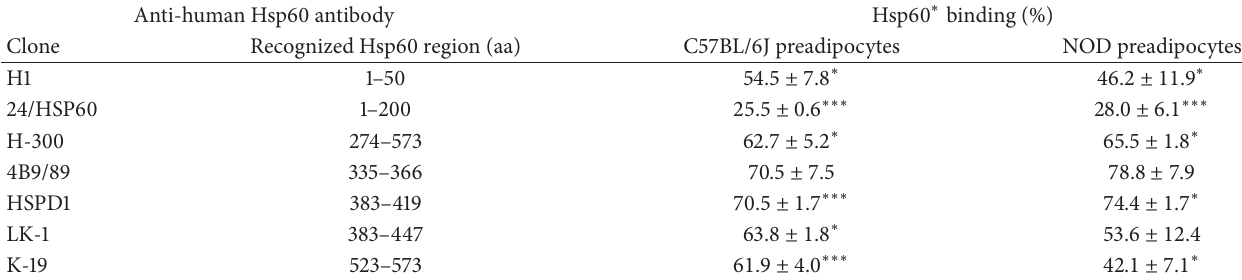
Table 1: Inhibition of Hsp60 binding to C57BL/6J and NOD mouse-derived preadipocytes by antibodies directed against defined Hsp60 regions.